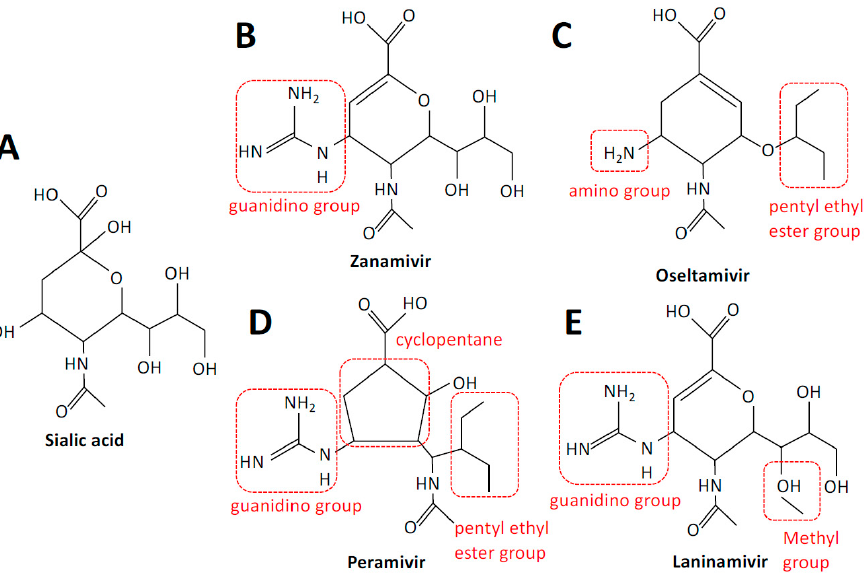
Figure 2. Structures of sialic acid and neuraminidase inhibitors. Sialic acid ( A ), zanamivir ( B ), oseltamivir ( C ), peramivir ( D ), and laninamivir ( E ). Structural elements are highlighted in red. Structures were adapted from PubChem.